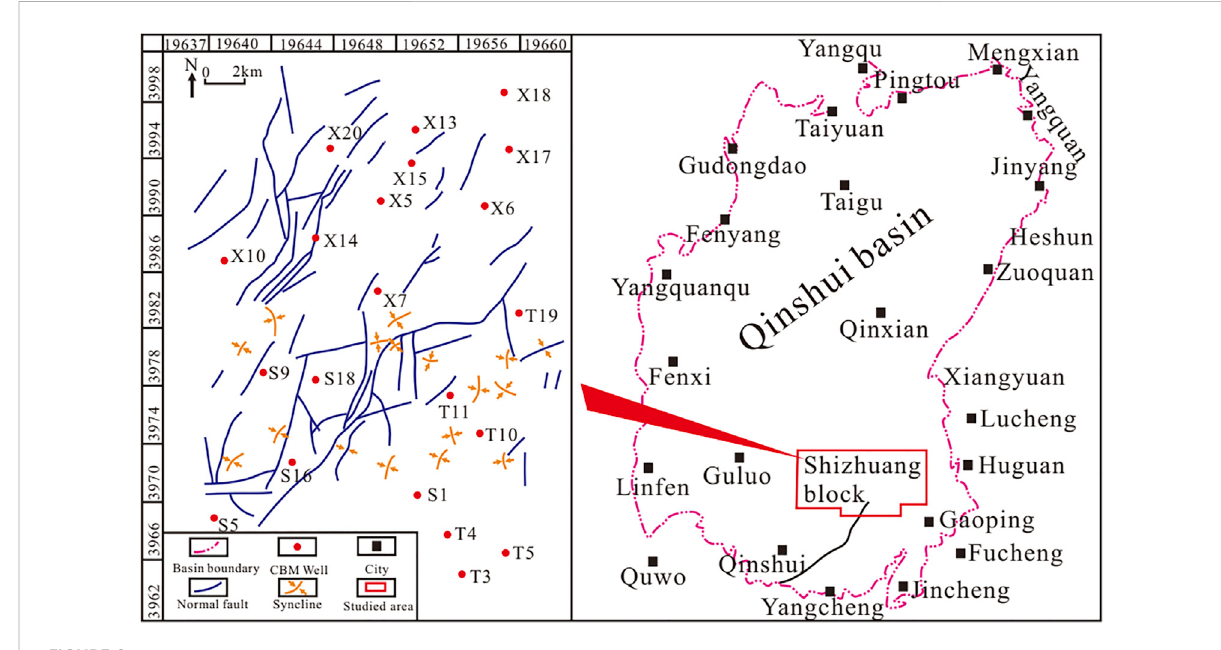
FIGURE 2 Structural topographic map of Qinshui Basin and the studied area.